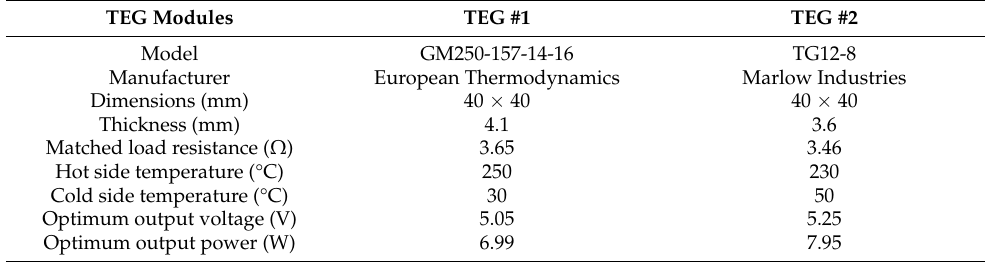
Table 2. Analyzed TEG modules.